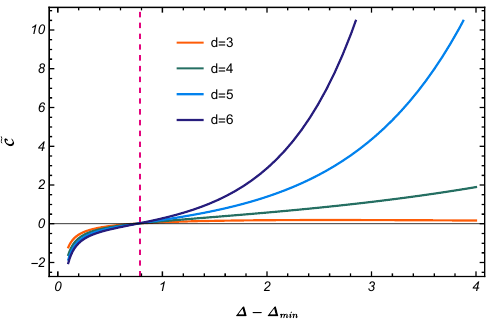
Figure 8 . e C as a function of scaling dimension for different values of d . The vertical dashed line at ∆ − ∆ min ∼ π indicates the critical point where ∆ E W ( O ) flips its 4